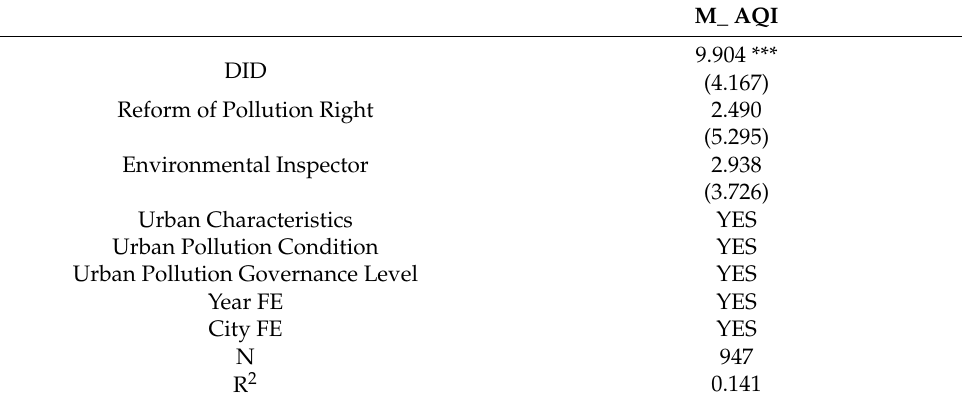
Table 5. Other Simultaneous